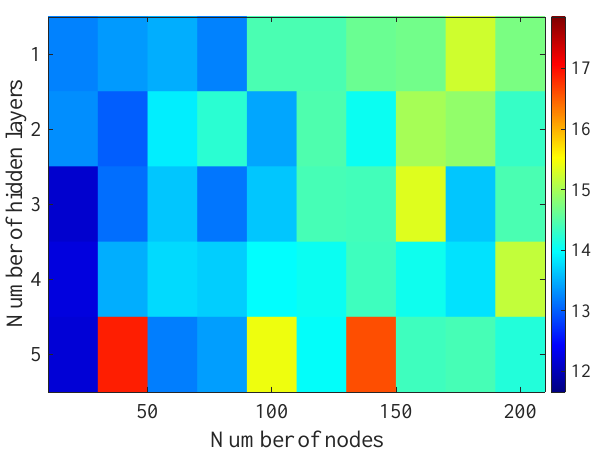
Figure 10. Matrix of the BLER RMSE metric predictions for the radio parameters history window W = 10.